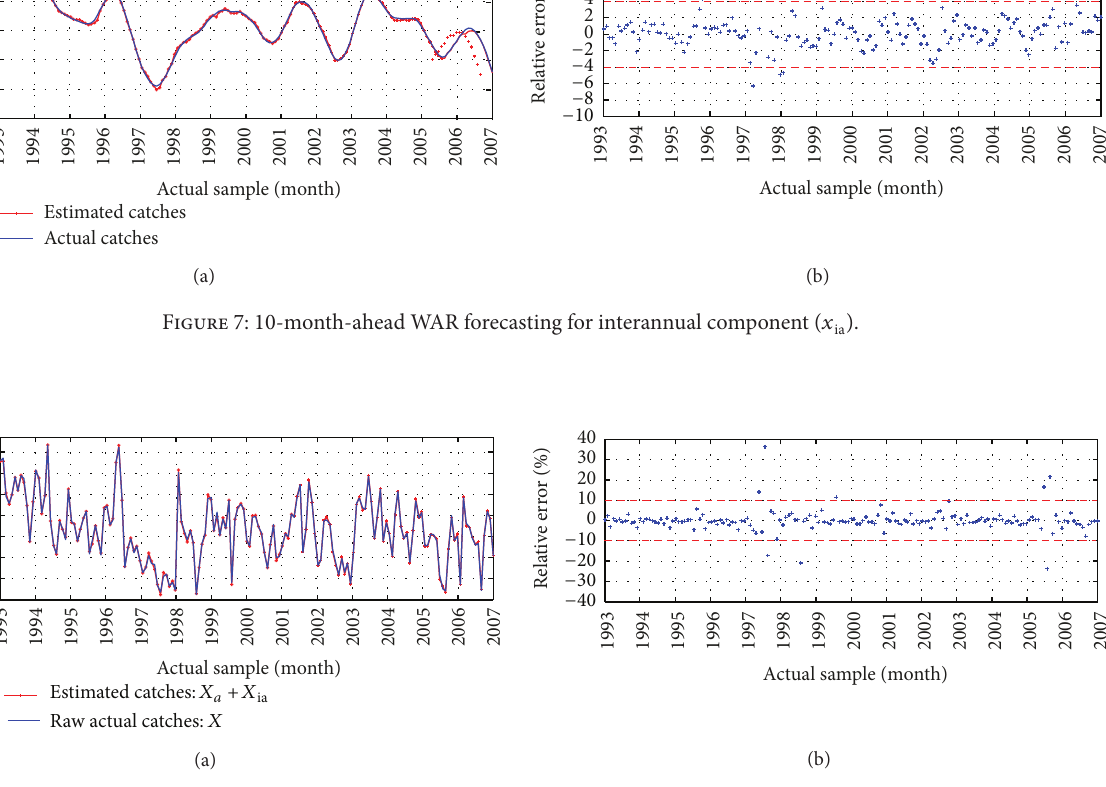
Figure 8: 10 -month-ahead WAR forecasting for observed anchovy catches versus estimated anchovy